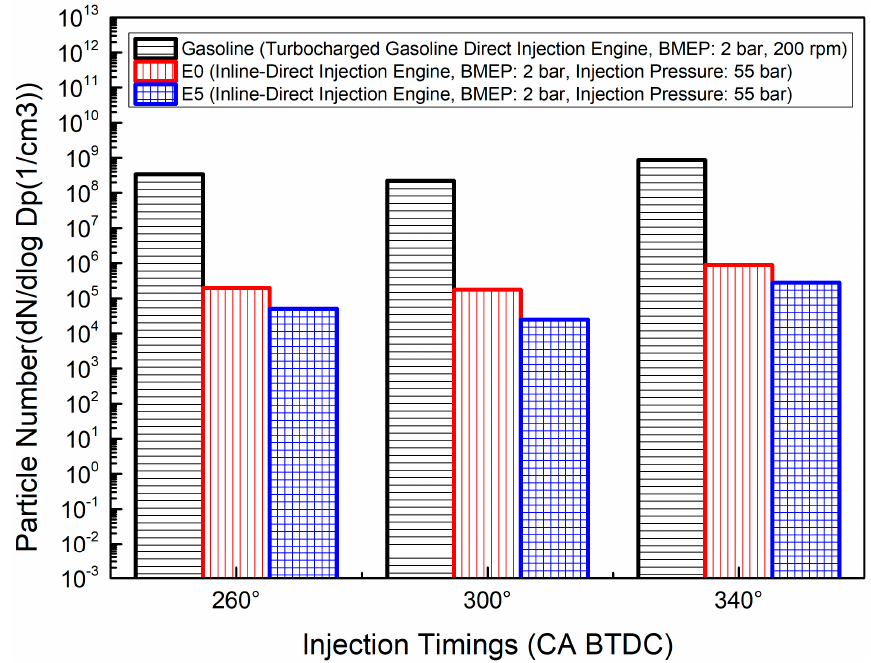
Figure 6. The impact of injection timings on PN emission (data from [69,72]).